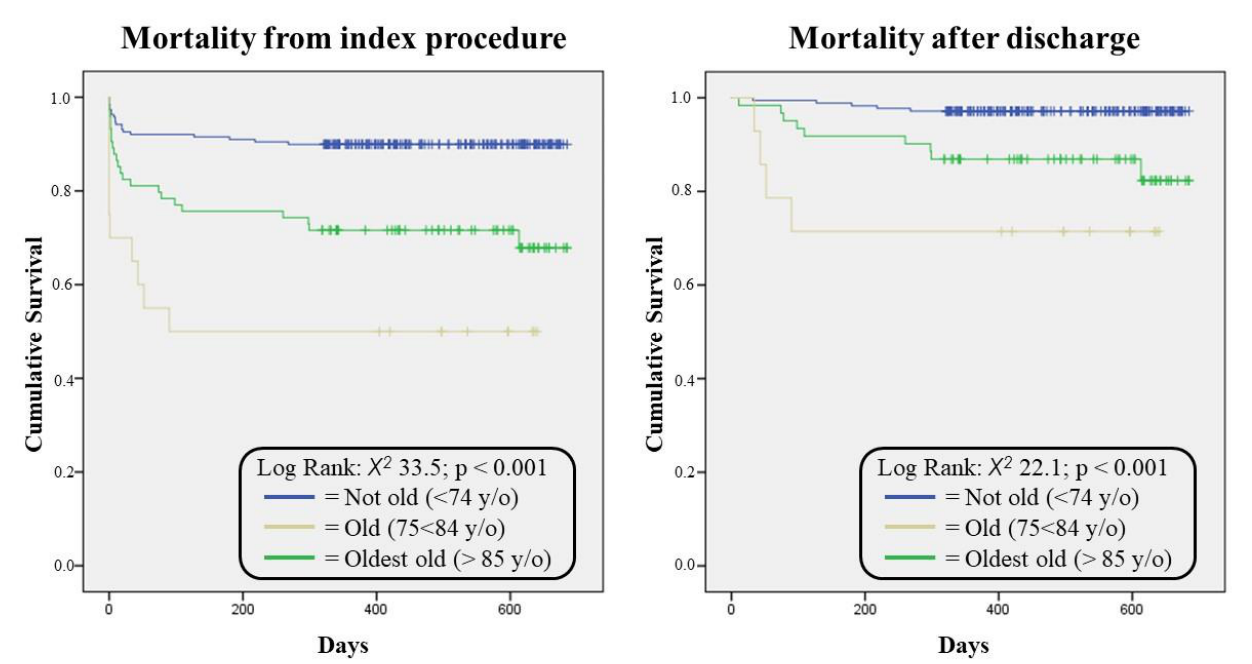
Figure 1. The cumulative survival rates of the three groups